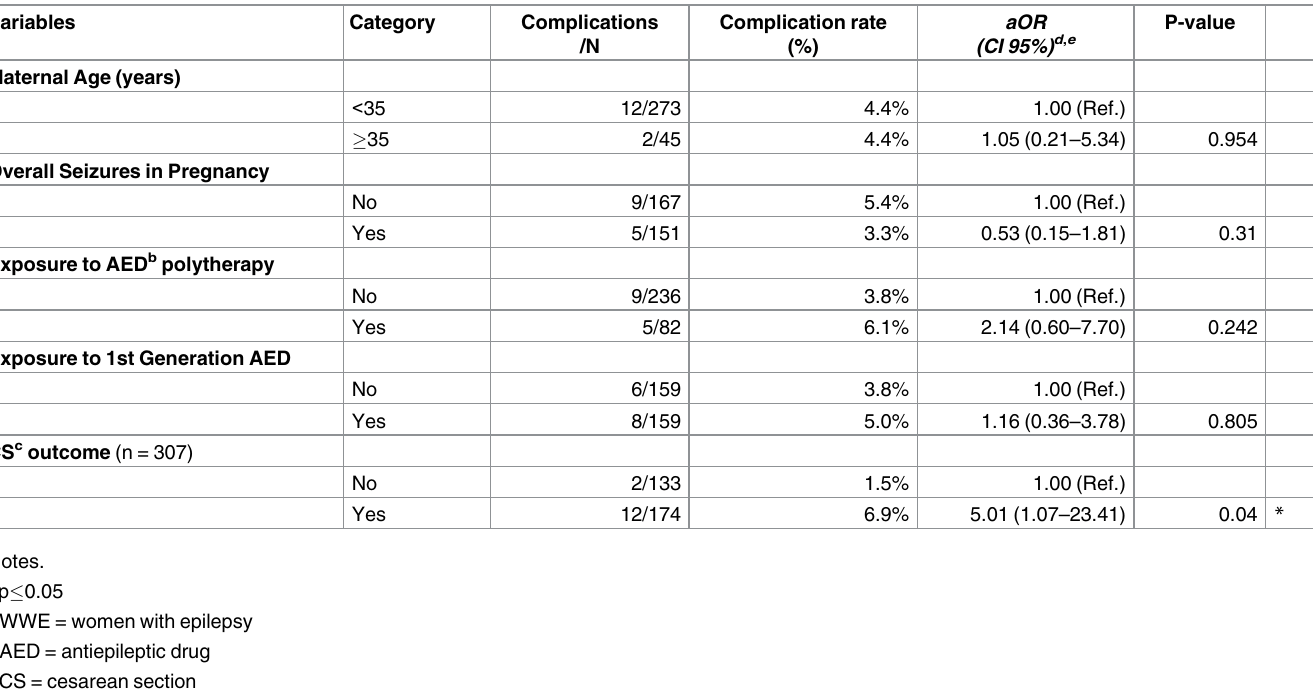
Table 3. Associated factors with maternal complications of WWE a pregnancies, n =